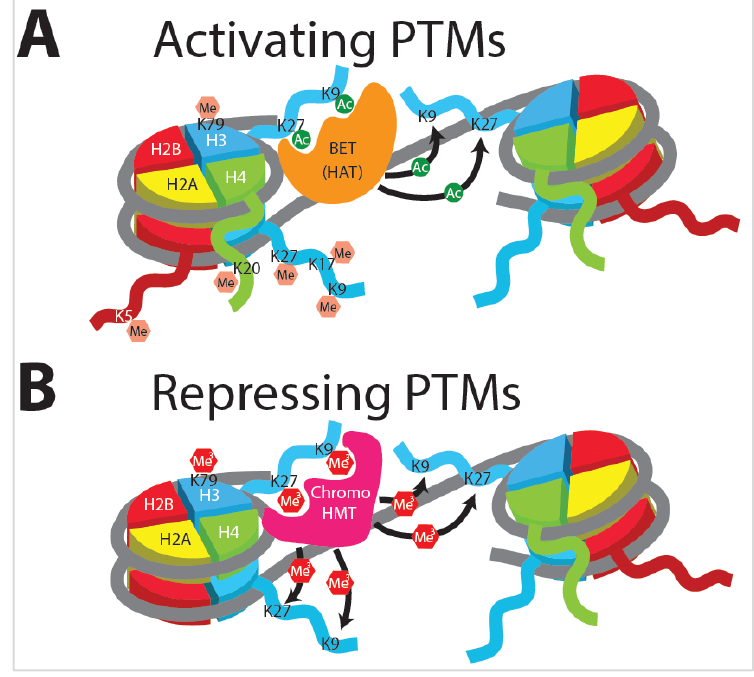
Figure 5. Transcriptional regulation is affected by histone protein post-translational modifications (PTMs). ( A ) Acetylation and monomethylation of specific histone-tail residues in nucleosomes results in activation of transcription. These marks can be transferred to adjacent nucleosomes by trans-acting proteins that bind to the modifications. ( B ) Trimethylation of specific histone residues results in repression of transcription. These repressive marks can in turn recruit other trans-acting proteins that transfer the repressive marks to neighboring nucleosomes.